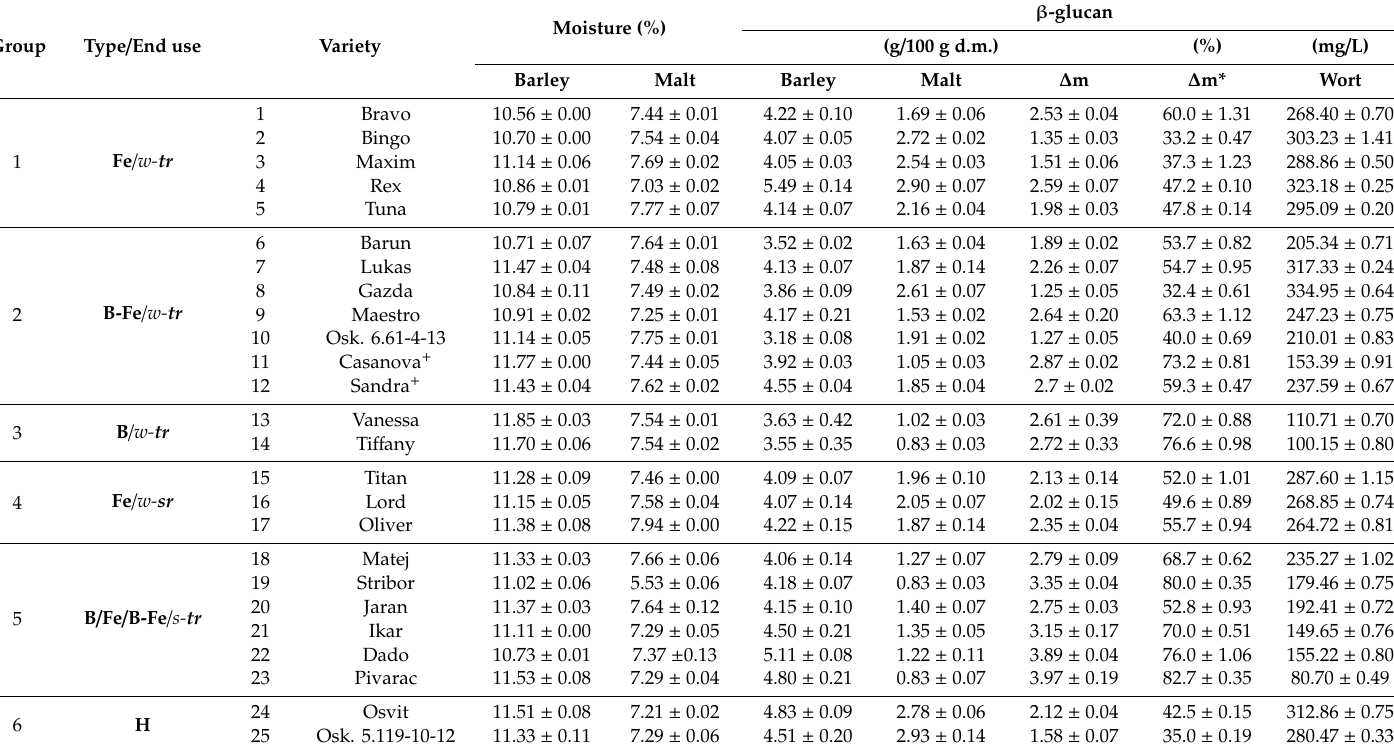
Table 2. Shares and mass di ff erence for β -glucan content in barley, malt, and